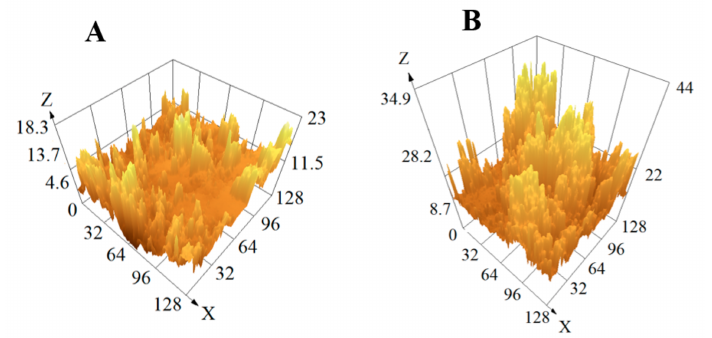
Figure 2. Topographic image of the ( A ) rGO-CTS and ( B ) Bi-rGO-CTS film surface obtained from confocal optical microscope (100 times of magnification). X and Z axes (scale, µ